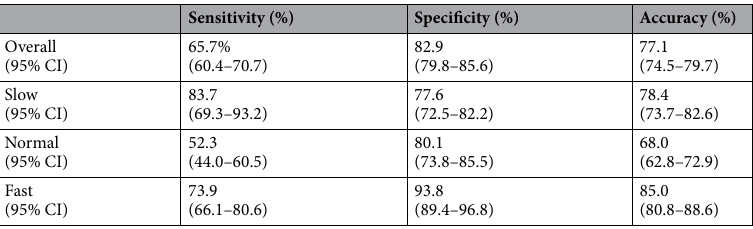
Table 6. Measures of sensitivity, specificity, and accuracy of speed of radial pulse. Spearman’s rank correlation coefficient: rs = 0.719, P < 0.001. SBP systolic blood pressure, PR pulse rate, bpm beats per minute, CI confidence interval. Radial pulse rate was categorised as follows: ‘slow’, PR = 49 bpm; ‘normal’ PR = 80 bpm; and ‘fast’, PR = 120 bpm. SPB 0 mmHg and PR 0 bpm data were excluded (n = 45). Incorrect answers regarding the presence of radial pulse were excluded (n =